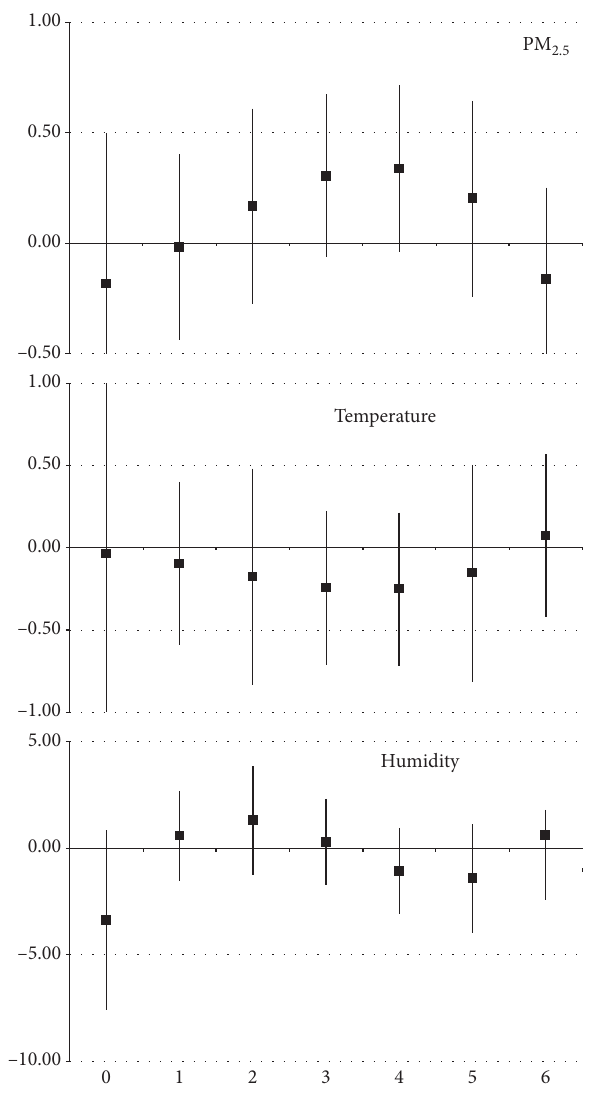
Figure 3: One interquartile range increase of daily mean level of PM 2.5 , for hospitalizations due to cardiovascular diseases in pa- tients over 60 years of age in Manaus (AM), from 2008 to